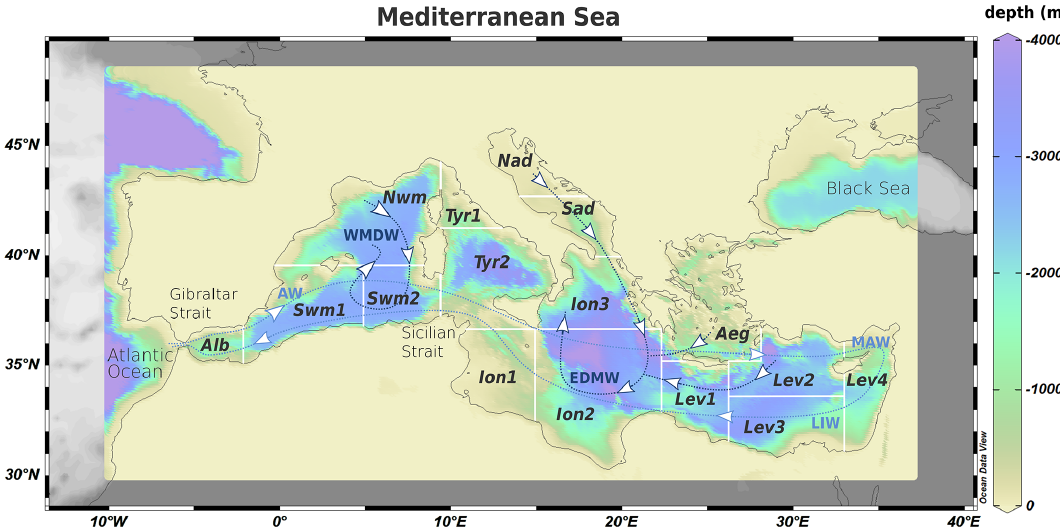
Figure 1. Bathymetric map of the Mediterranean Sea (from Ocean Data View, Schlitzer, 2014). The white contours indicate the subdivision of the model domain in subbasins: Alboran Sea (Alb), Southwestern Mediterranean (Swm1 and Swm2), Northwestern Mediterranean (Nwm), Tyrrhenian Sea (Tyr1 and Try2), Northern Adriatic Sea (Nad), Southern Adriatic Sea (Sad), Ionian Sea (Ion1, Ion2, and Ion3), Aegean Sea (Aeg), and Levantine Sea (Lev1, Lev2, Lev3, and Lev4). The light blue line shows the zonal cell driven by the surface inflow of Atlantic Water (AW) that moves eastward, forming Modified Atlantic Water (MAW) and Levantine Intermediate Water (LIW), outflowing at intermediate depths at the Strait of Gibraltar. The dark blue lines show the path of meridional cells related to winter convection in the Nwm, Nad, Sad, Aeg, and Lev originating the Western and Eastern Mediterranean Deep Water (WMDW and